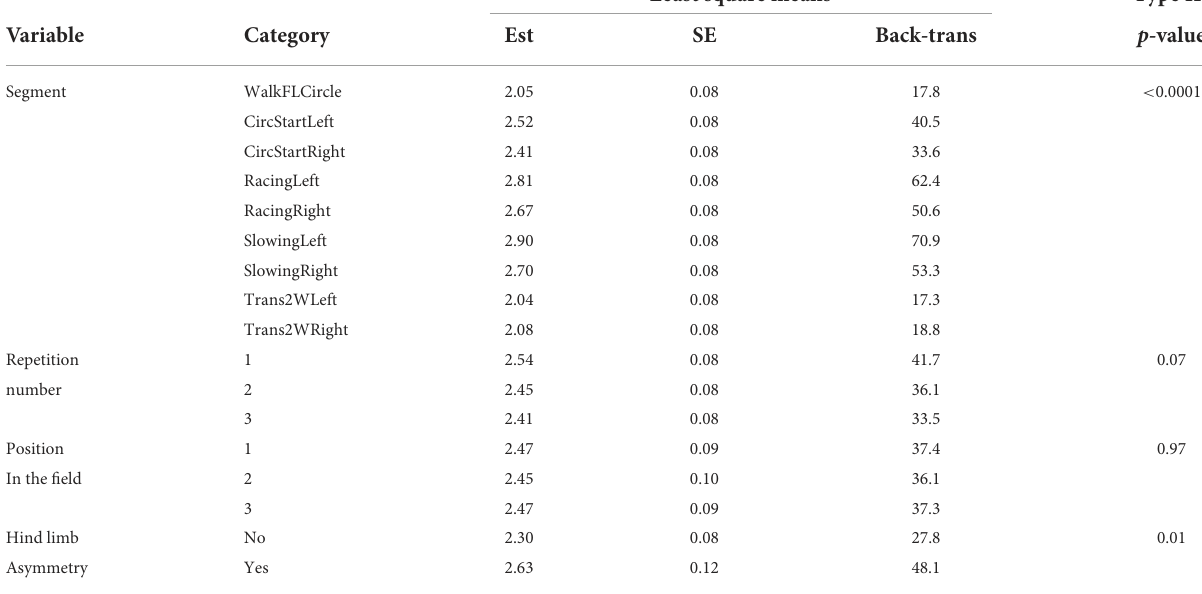
TABLE 2 Least square means (478 observations, 11 drivers and 9 horses) from model results with segment median rein tension as the outcome variable (modeled fourth-root transformed) and p -values for the corresponding main